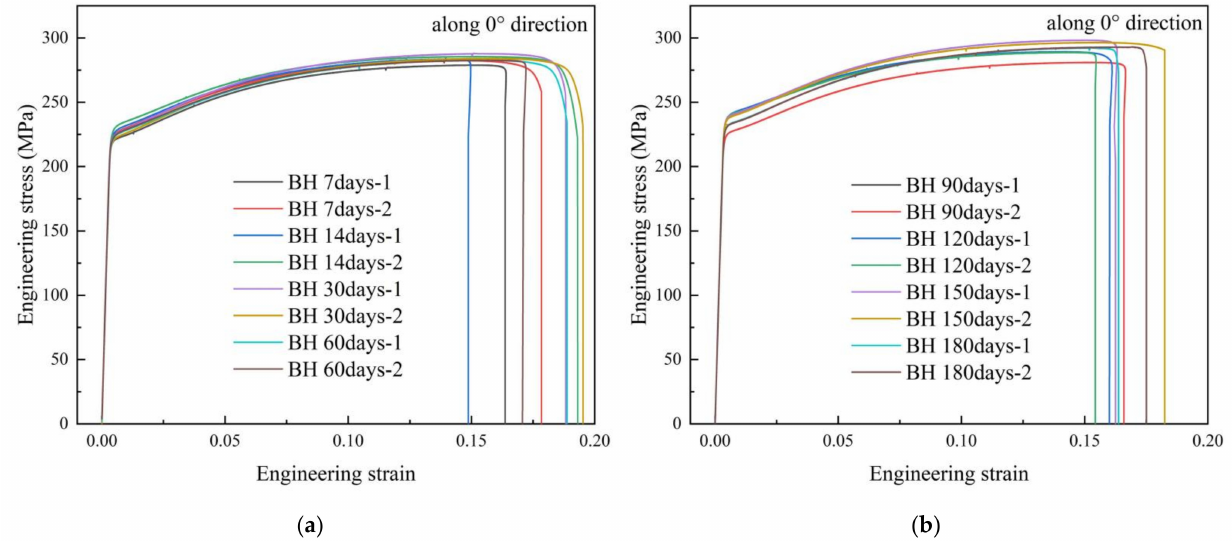
Figure 10. Bake hardening tensile curves obtained after different NA time along 0 ◦ direction: 7–60 days ( a ); 90–180 days ( b